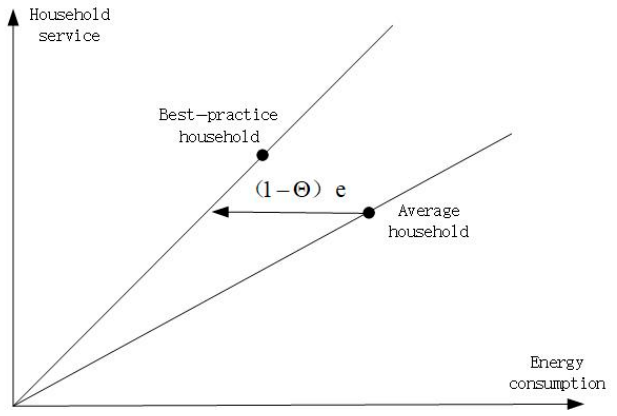
Figure 1. Household’s energy-saving